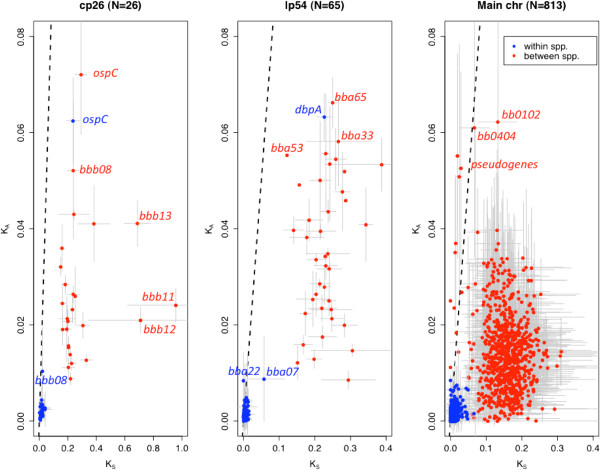
Synonymous and nonsynonymous substitution rates of genes. Each point represents the average synonymous (KS) and nonsynonymous (KA) rates between B31 and other strains for a given ORF locus. The average was obtained separately for comparisons of B31 with a strain of the same species (in blue) and with a strain of a different species (in red). Gray lines show one standard deviation of these within- and between-species comparisons. Within each panel, a dash line indicates the neutral expectation (KA =KS).